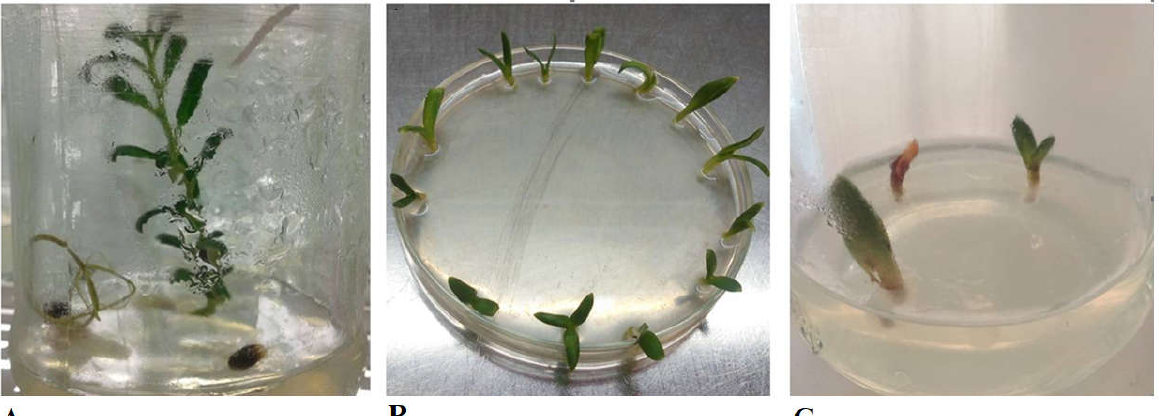
Fig.1. Different stages from Germination of N. schoberi to regeneration in selective medium: A) in vitro culture of seed germination; B) Inoculation of cotyledonary leaves with Agrobacterium ; C) Plantlet regeneration in selective medium supplemented with the